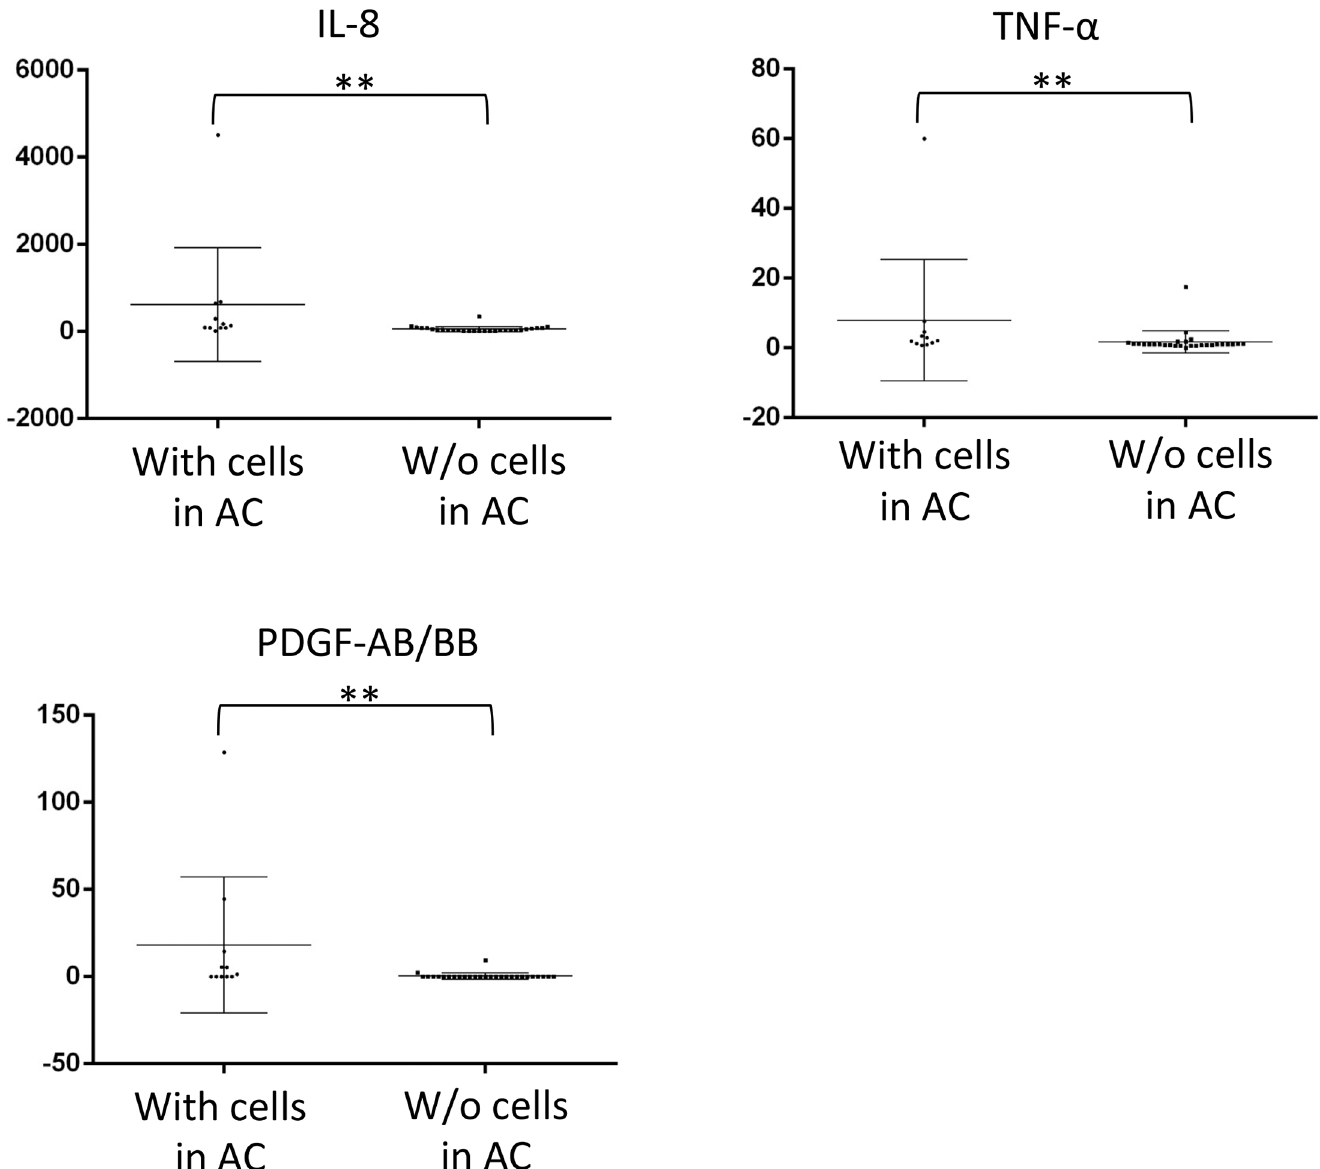
Fig 3. Comparison of levels (pg/mL) of analytes in eyes of UG cases between with and without cells in anterior chamber. Data points ( n = 11 for with cells and n = 28 for without cells in anterior chamber) represent individual samples. Error bars indicate medians ± interquartile range. ** P < 0.01. AC, anterior chamber, IL, interleukin, PDGF, platelet-derived growth factor, TNF, tumor necrosis